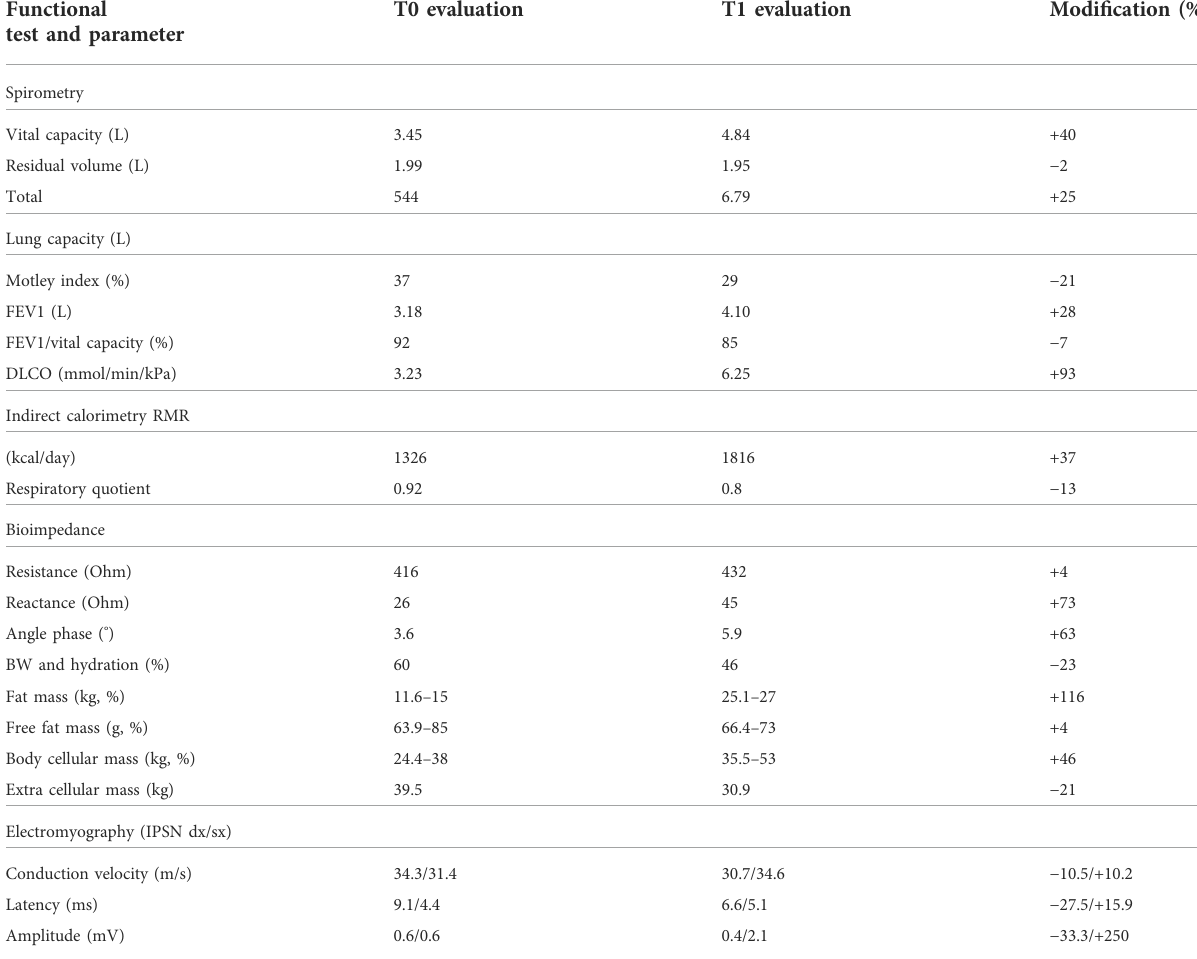
TABLE 1 Absolute and percentage changes of the functional parameters measured at the beginning and at the end of the AMA intervention. Functional test and